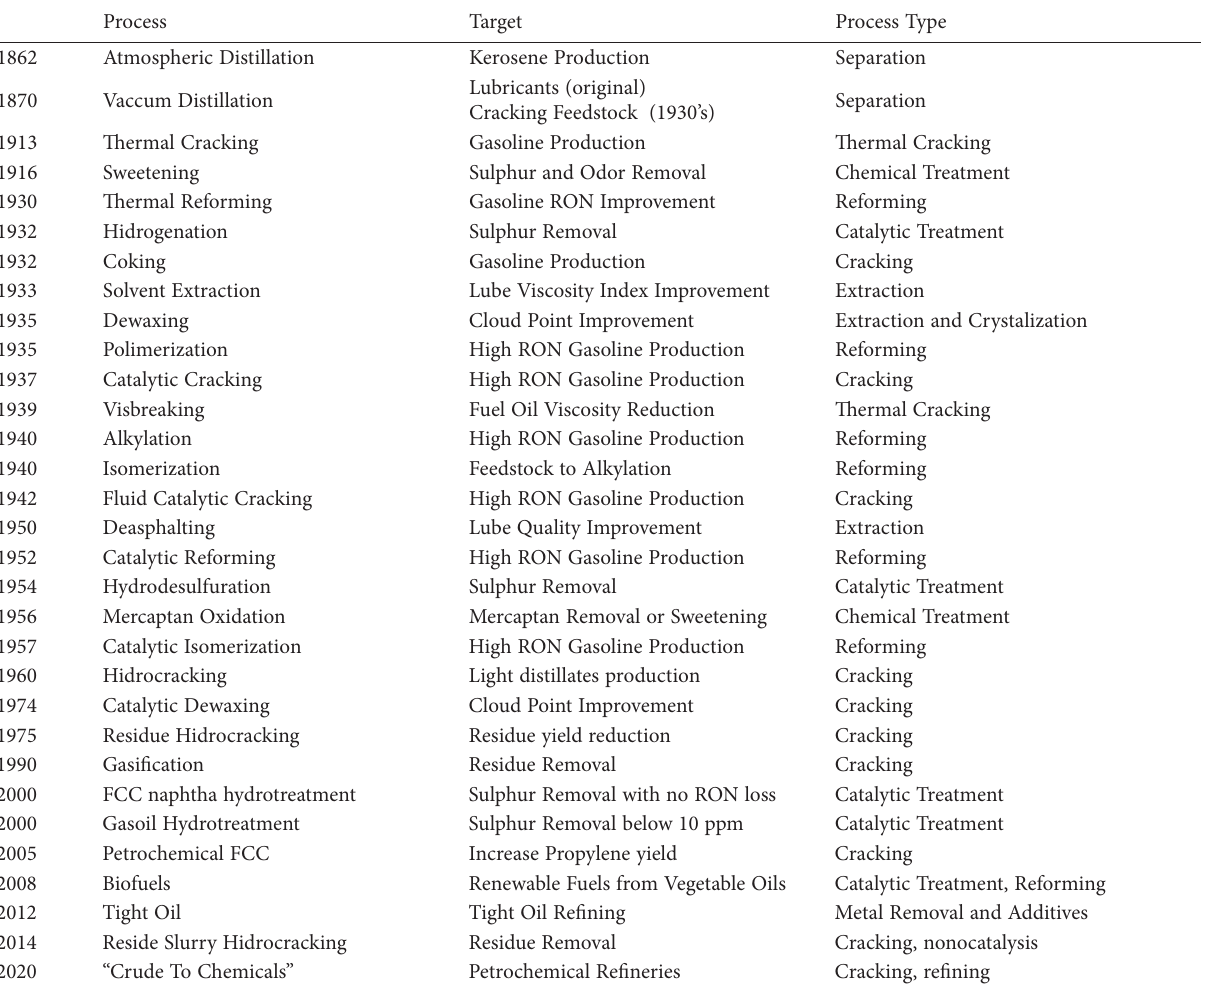
Table 1. Oil Refining Process